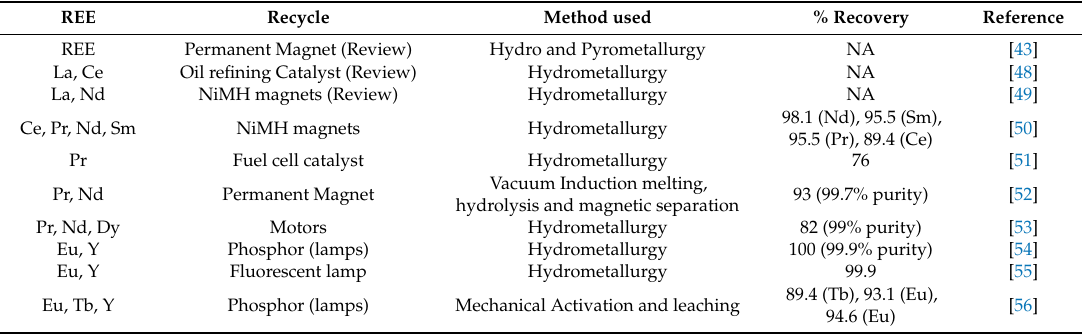
Table 3. The use of hydrometallurgical methods for the recovery of REEs from end-of-life products, according to the studies published in 2016